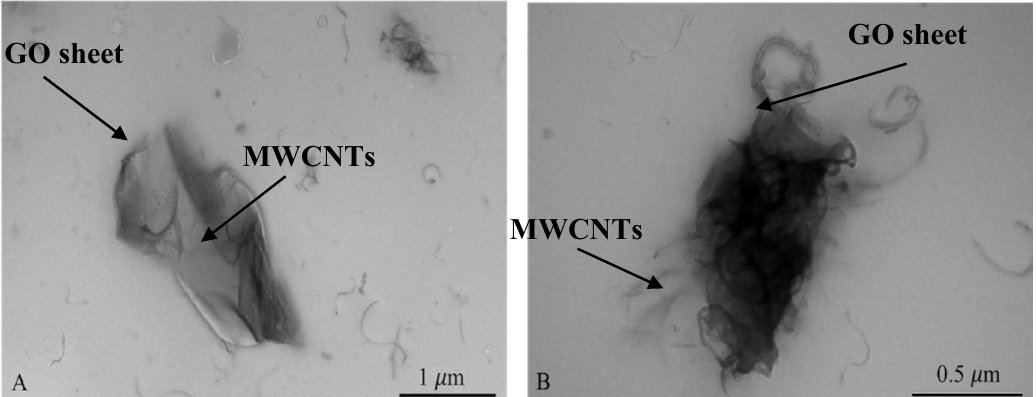
Figure 1. TEM images for the GO ‐ MWCNT nanocomposites in CHT which were used for the modification of GCE surface (scale bars for image A to B are 1.0 and 0.5 μ m).